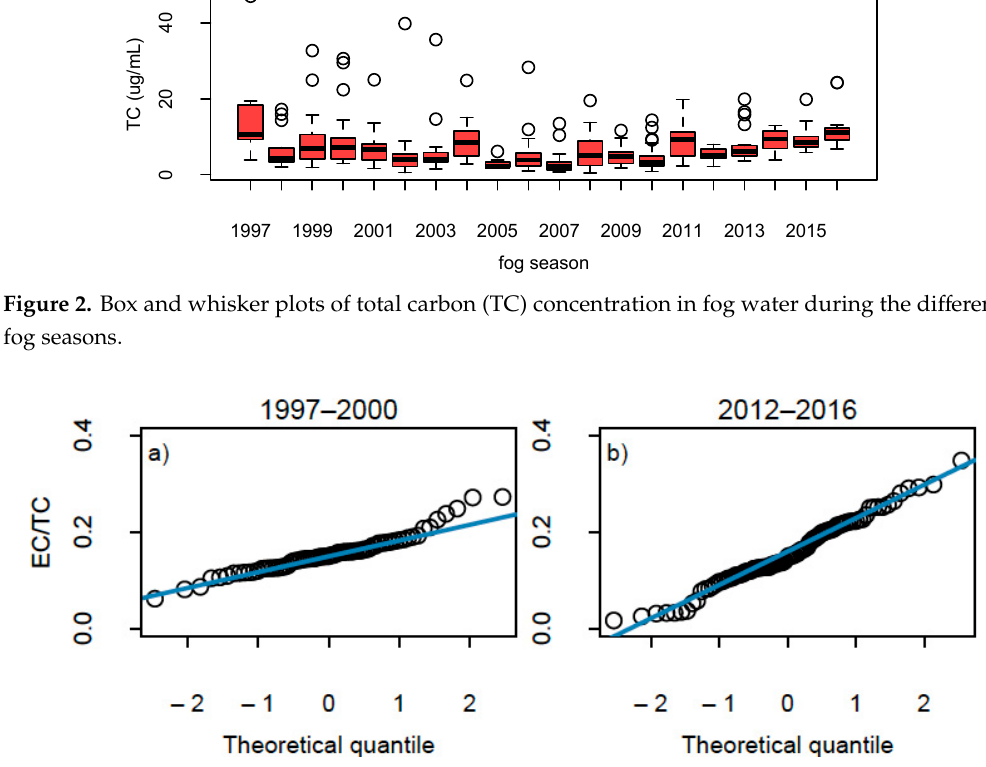
Figure 3. Q-Q plot of EC to total carbon ratio from 1997 to 2000 (panel a), and from 2012–2016 fog season (panel b). The blue line indicates the theoretical normal distribution.